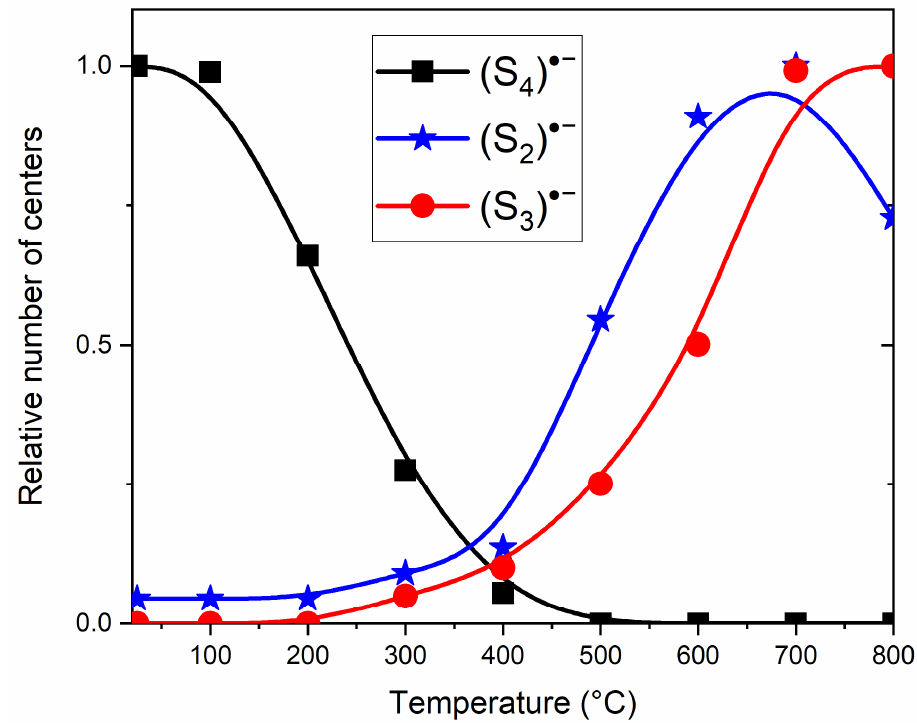
Figure 13. Relative amounts of various sulfur radical anions in haüyne (Sample 3) heated at different temperatures. The values of the relative amounts are normalized to the maximum number of each of the radical anions.